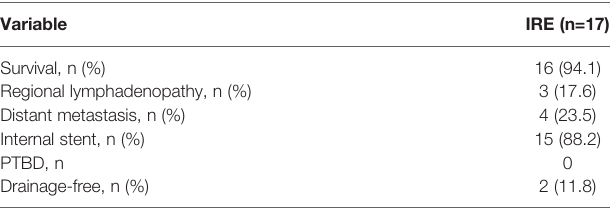
TABLE 2 | Outcome of patients at one year after IRE. Variable